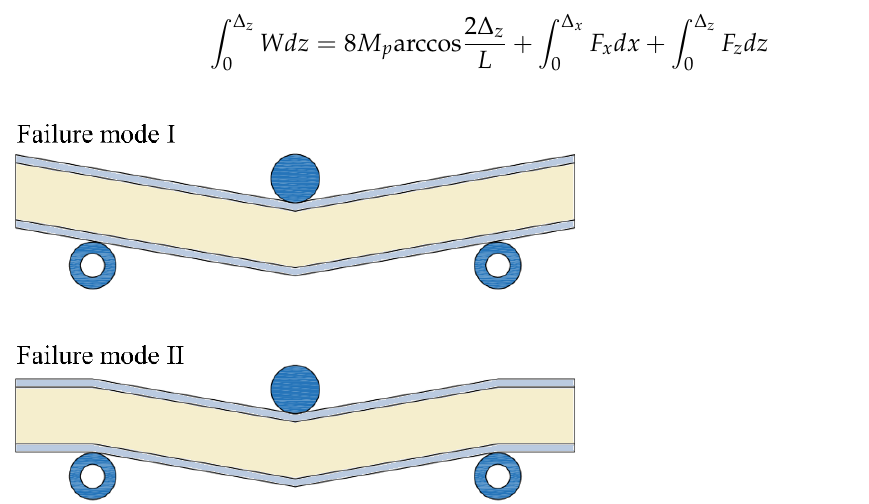
Figure 14. Schematic of deformation modes for the panel-to-panel construction under three-point bending.